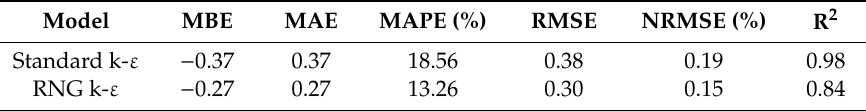
Table 3. Error indices of the numerical models for x i / ( d · F